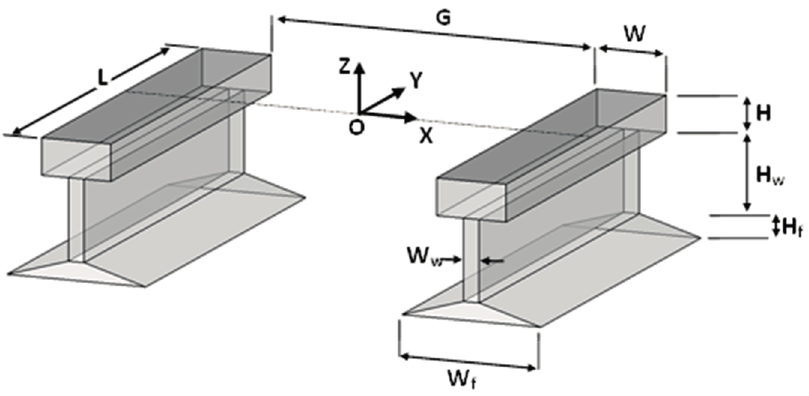
Figure 6. Parametric model of a pair of two rail pieces. Position and the orientation parameters of the local coordinate system need to be